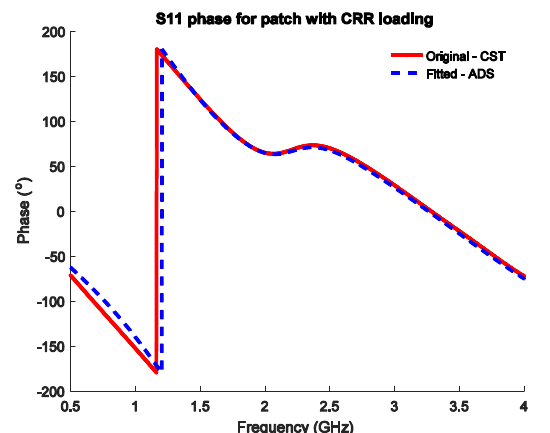
Figure 18: S11 original and fitted magnitude with CRR defected ground.